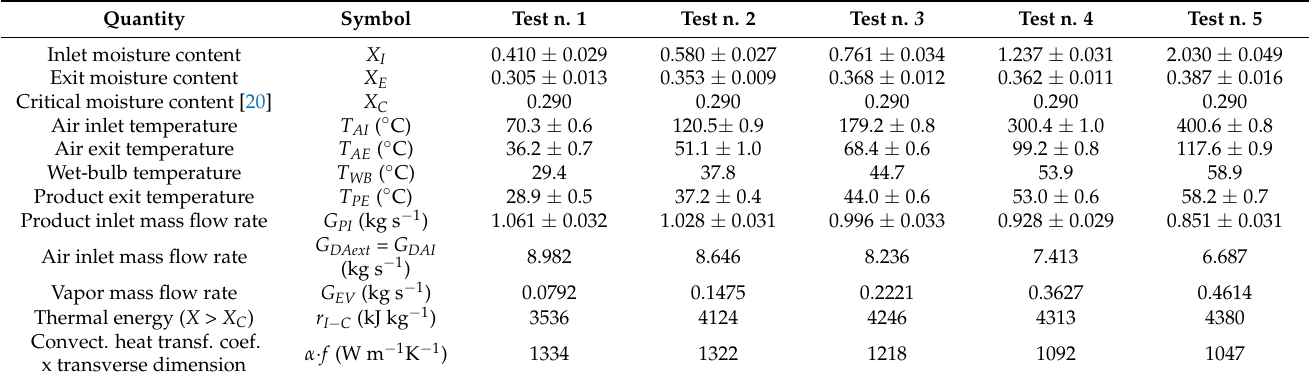
Table 2. Experimental results from tests described in Section 2.4, Section 2.5, and Section